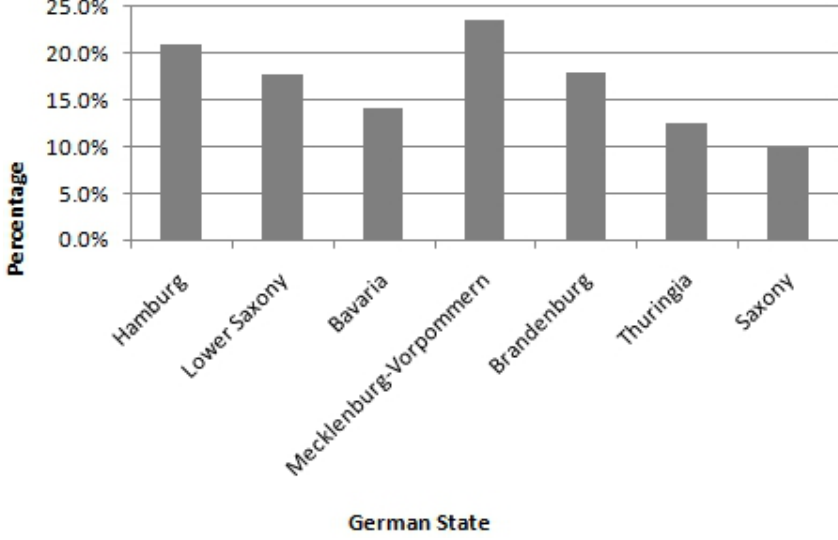
Figure 2. Smoking behavior of pregnant women in different German states 1998–2000; with kind permission and modified after [5]